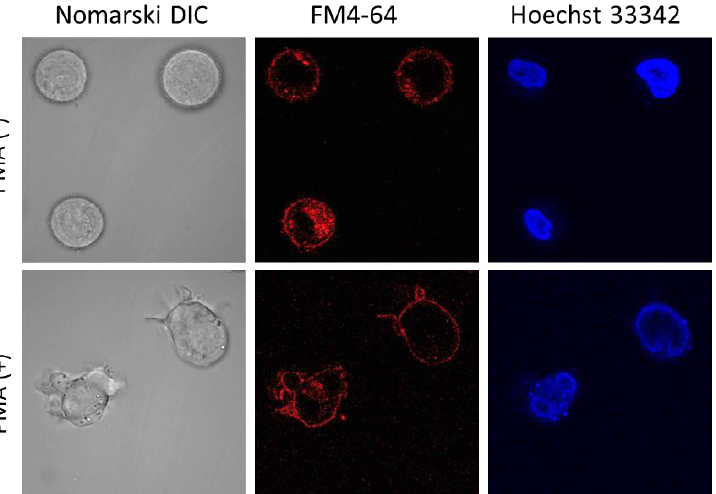
Figure 4. Double staining using FM4-64 and Hoechst 33342 in nondifferentiated (upper panel) and 72 h differentiated (lower panel) U-937 cells incubated for 5 min. Images (magnification 1000×) were taken in different channels (from left to right are Nomarski DIC, FM4-64, and Hoechst 33342). When cells such as U-937 cells are exposed to inducers such as PMA, their prolifera- tion slows while the differentiation process is triggered. The monocytes under the PMA treatment are known as “macrophage - like” because of their structure [39 – 41]. However, the properties of the transformed cell line are not yet well-known. Phorbol 12-myristate 13-acetate works as a tumor promoter, and it is known to be involved in gene transcrip- tion, cell growth, differentiation, immune pathway, programmed cell death, and receptor desensitization through PKC signaling pathways [42]. It also starts to induce adherence accompanied by cell cycle arrest [43]. PMA is also known to activate the calcium- and phospholipid-dependent isoforms of PKC, thus inducing AMP metabolism, leading to its maturation into a macrophage. It is now well-accepted that adding PMA exogenously ac- tivates the NADPH oxidase complex, which can lead to the formation of O 2 ●− . In the pres- ence of SOD, it can create H 2 O 2 and subsequently HO ● [3,43 – 46].